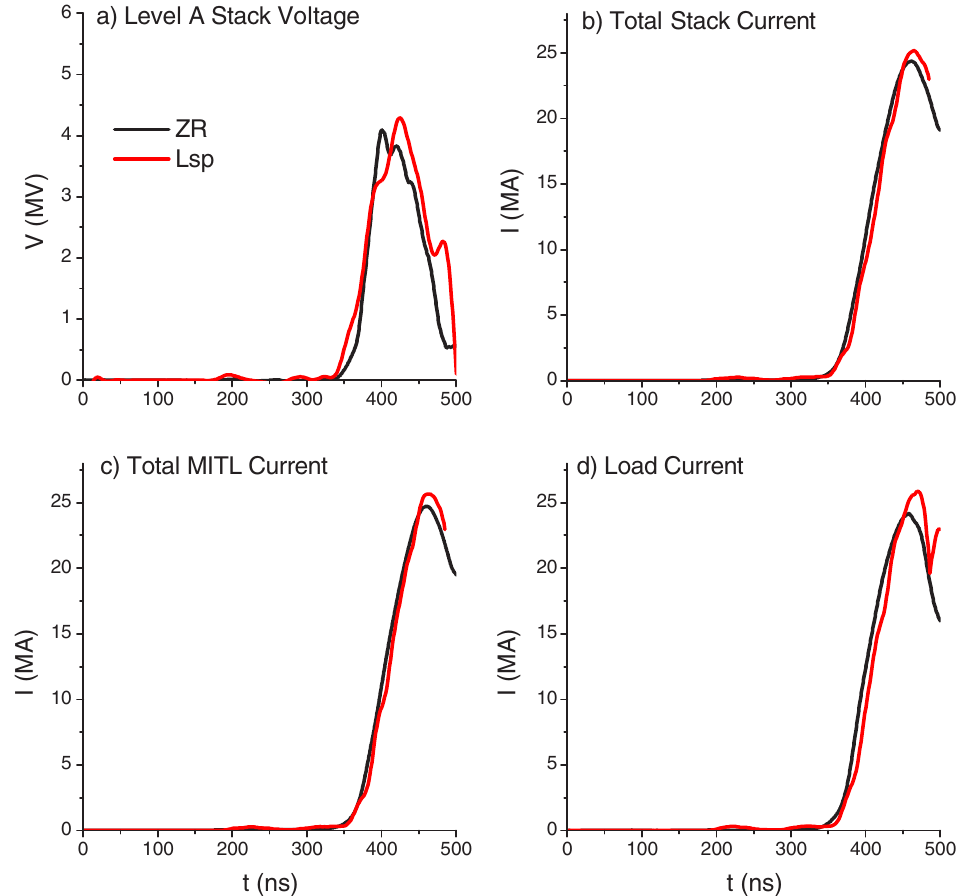
FIG. 6. (Color) Comparison of measured and simulated electrical signals at (a), (b) the insulator stack, level A, (c) the current in the level A MITL, and (d) the load